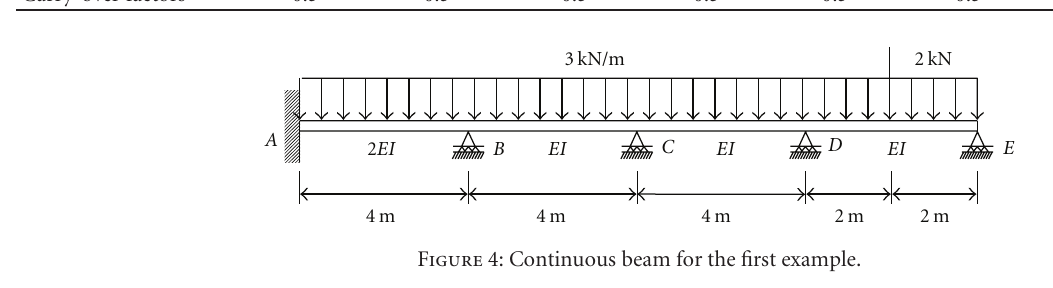
Table 1: Initial moments at the ends of the members and the distribution and carry-over factors for the first example. Node A B C Members Fixed-end moments Distribution factors Carry-over factors